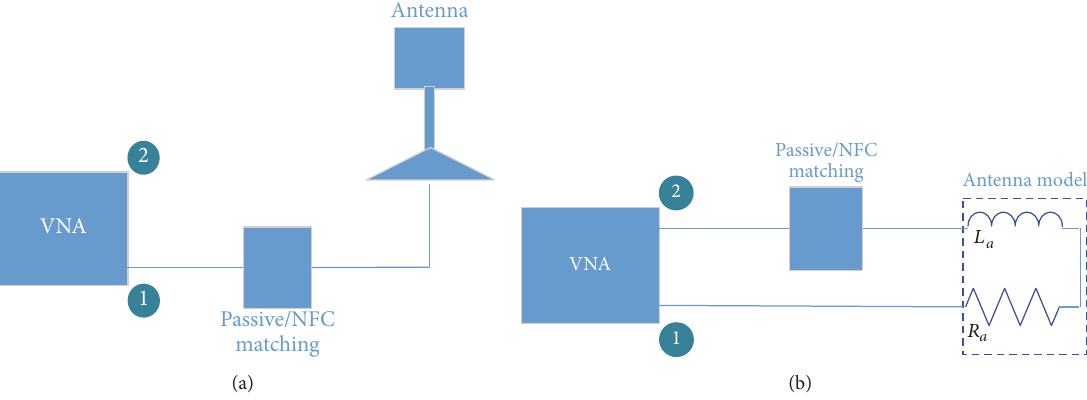
Figure 9: (a) 𝑆 11 measurement diagram for non-Foster matched antenna and passive antenna; (b) 𝑆 21 measurement diagram for non-Foster matched antenna and passive antenna (the passive matching and non-Foster matching circuit are attached to the antenna, resp.).